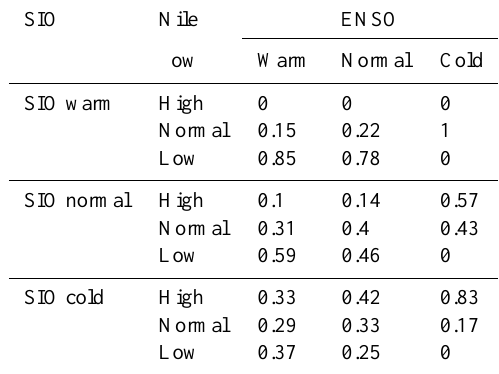
Table 5. Conditional probability of the Nile flow given SIO and ENS